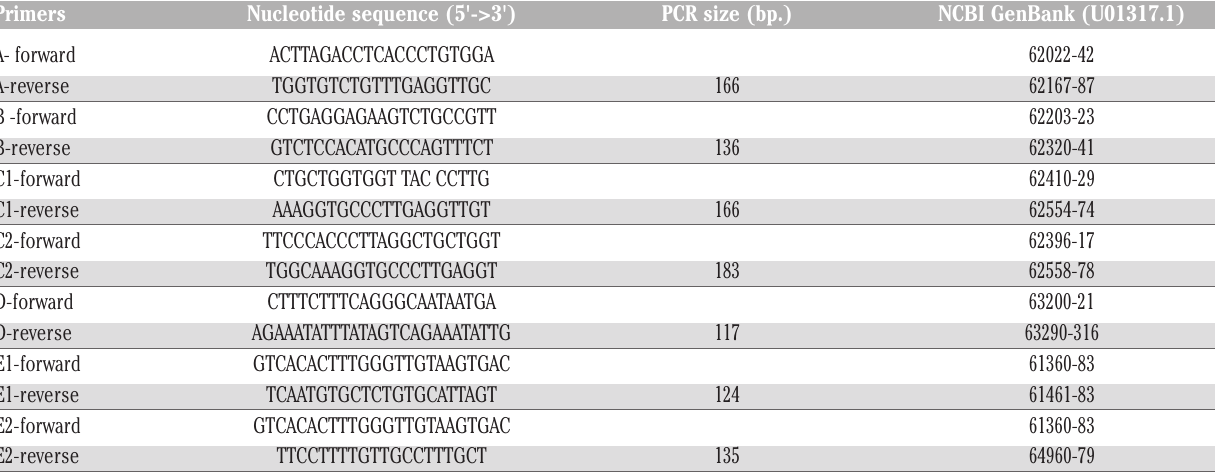
Table 1. Primer sequences for PCR-HRM detection of common beta thalassemia mutations in Thailand.